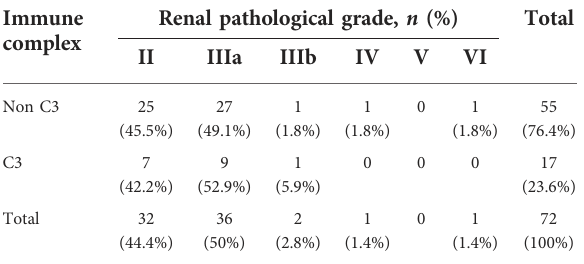
TABLE 7 Relationship between renal pathological grade and C3 deposition. Immune Renal pathological grade, n complex